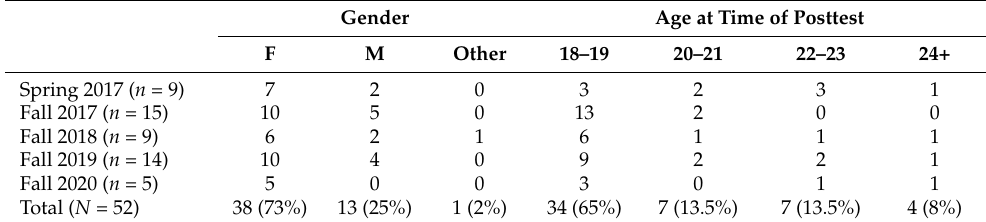
Table 2. Gender and age of participants.